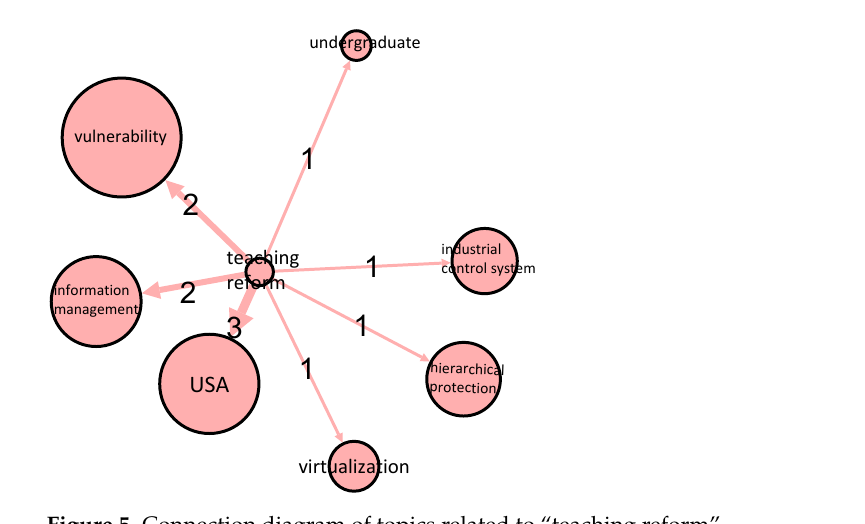
Figure 5. Connection diagram of topics related to “teaching reform”.